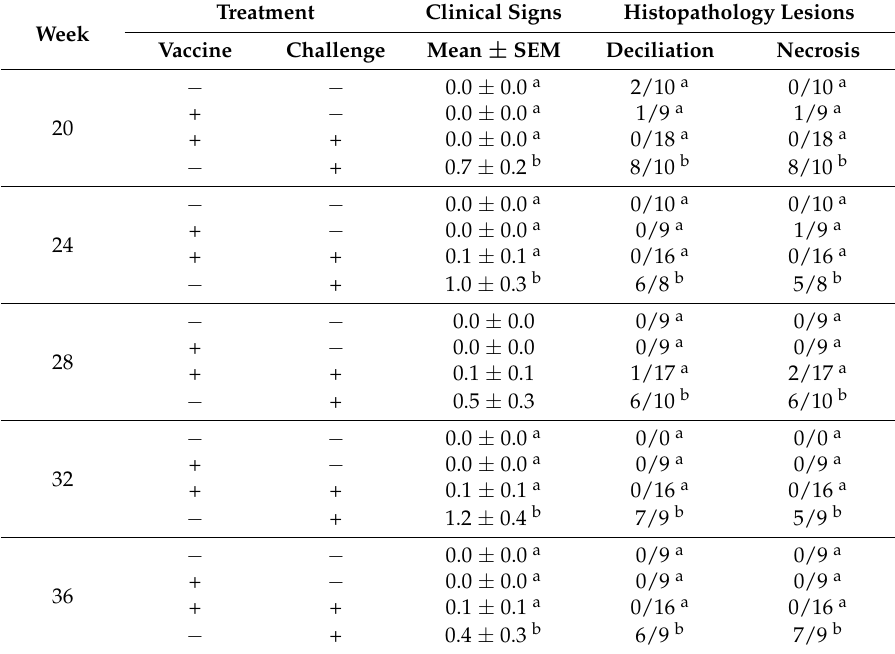
Table 2. Clinical signs and microscopic lesions measured 5 days following IBV GA98 challenge. Letters (a–b) indicate significant differences among vaccine and challenge groups for each week ( p <